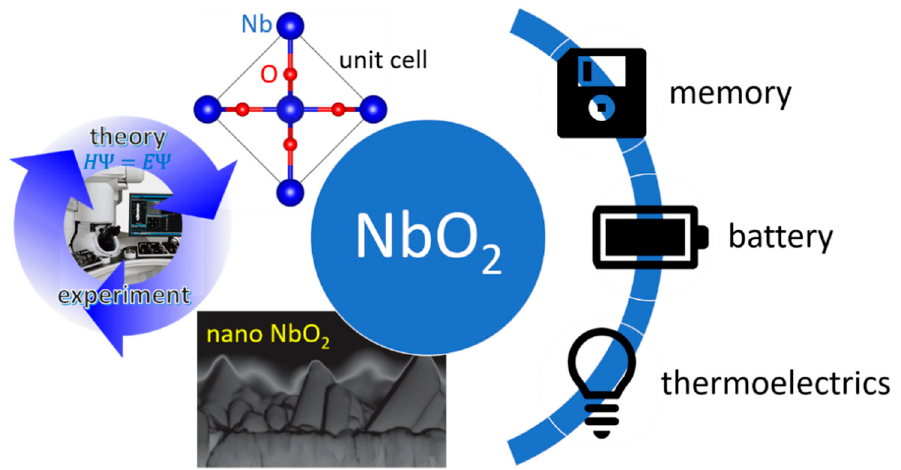
Figure 1. Synergy of theoretical and experimental methods employed on nanostructured NbO 2 to open up possibilities for many high-tech applications. This review is congregated around memory and energy thin film devices.